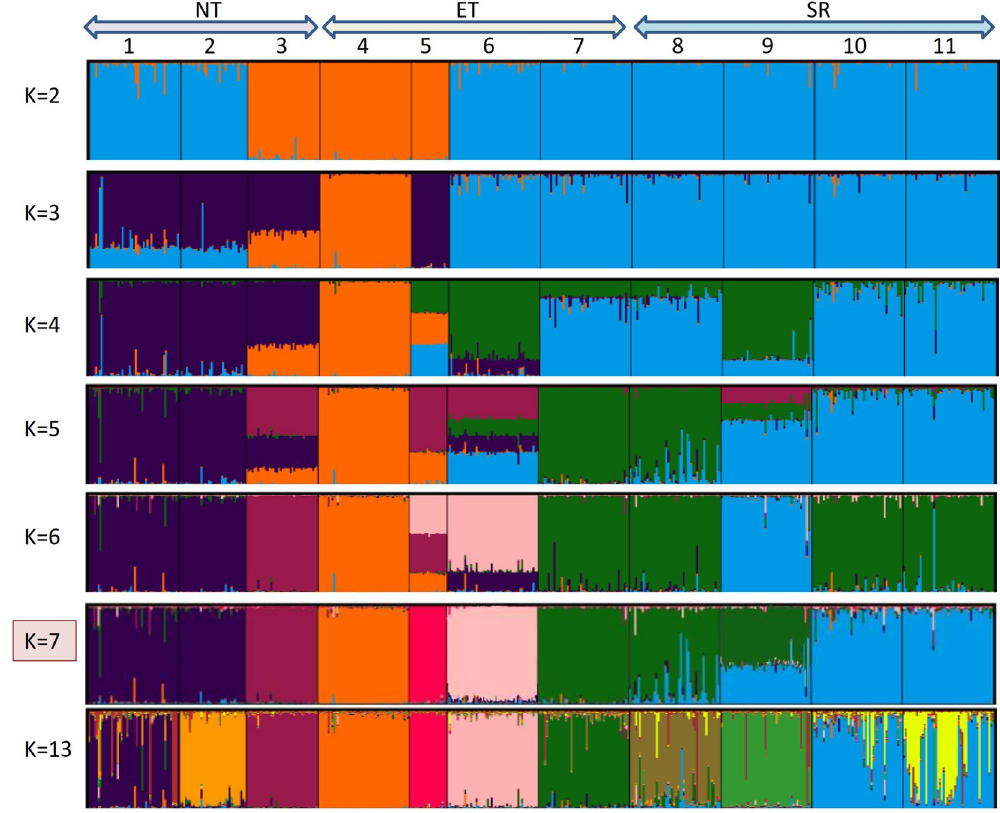
Figure 4. Bayesian clustering of Indian sheep populations under assumption of K = 2–7, and K = 13 clusters using STRU CTU RE 2.3.4 program 53 . Each individual is represented by a vertical bar displaying membership coefficients for each genetic cluster. Populations are separated by black lines and denoted by numbers (1 = Rampur Bushair, 2 = Poonchi, 3 = Changthangi, 4 = Bonpala, 5 = Tibetan, 6 = Shahbadi, 7 = Balangir, 8 = Kenguri, 9 = Bandur, 10 = Hassan, 11 = Bellary). Graphics were obtained with DISTRUCT 55 (https ://rosen bergl ab.stanf ord.edu/) and CLUMPP 54 (https ://web.stanf ord.edu/